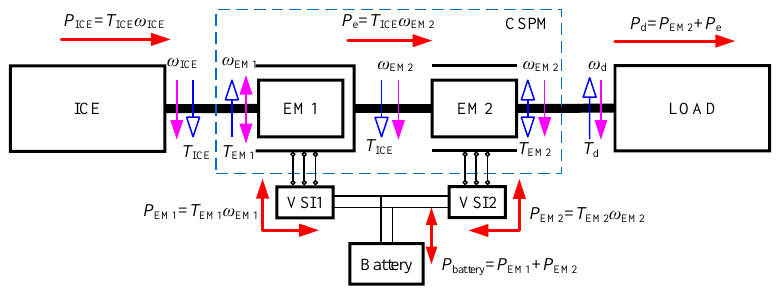
Figure 3. Hybrid mode and the related power flow diagram.